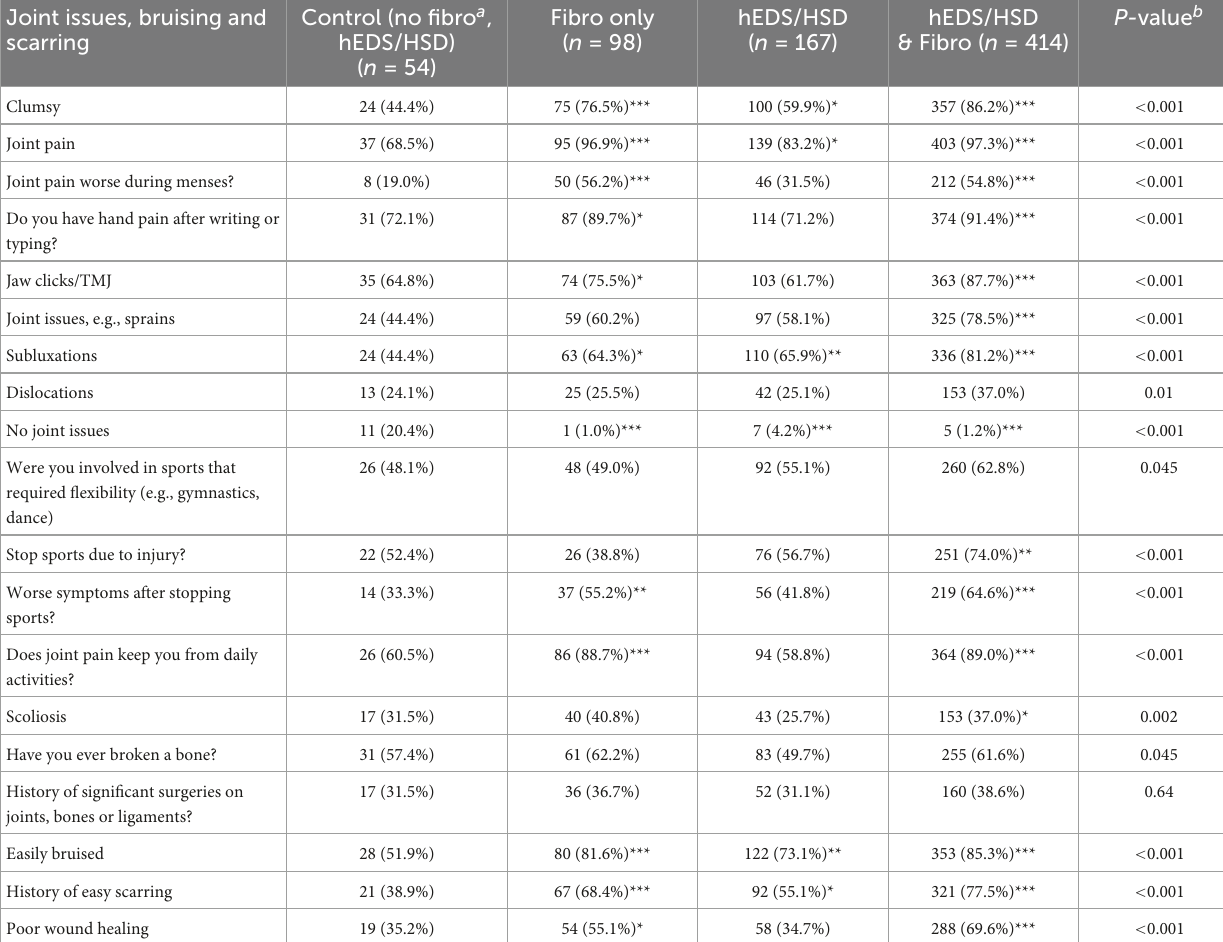
TABLE 3 Joint issues, bruising, and scarring in female and male patients diagnosed with fibromyalgia, hypermobility (hEDS or HSD) or hEDS/HSD and fibromyalgia compared to controls ( n = 733). Joint issues, bruising and